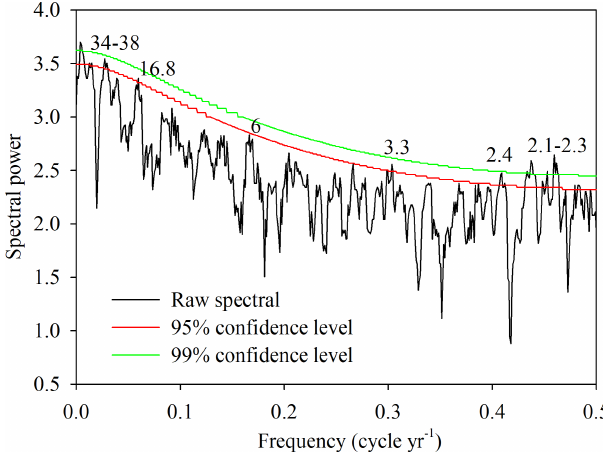
Figure 7. The multi-taper method spectrums of the reconstructed scPDSI from 1593 to 2016. The red and green line represent the 95% and 99% confidence level, respectively. The figures above the significance line represent significant periods of drought at the 95% confidence